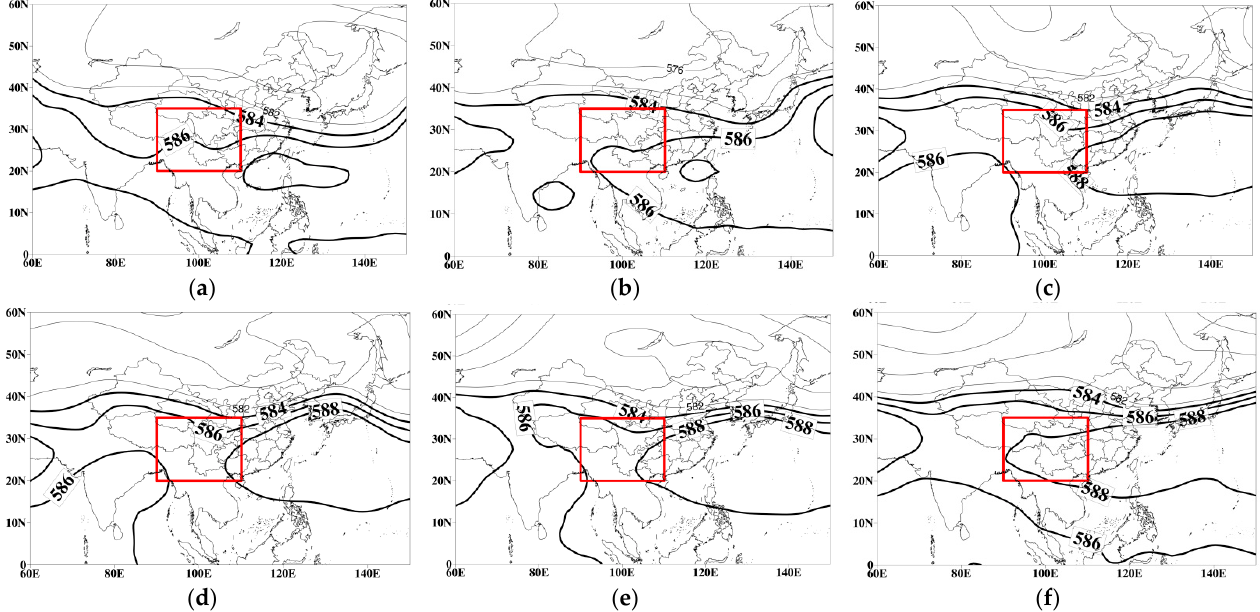
Figure 21. Homochromous 500 hPa height field in the second cycle of 30–60 days ISO in 1998. (Unit: dagpm; ( a – f ) means phases 1–6; area in red box is southwest China.).